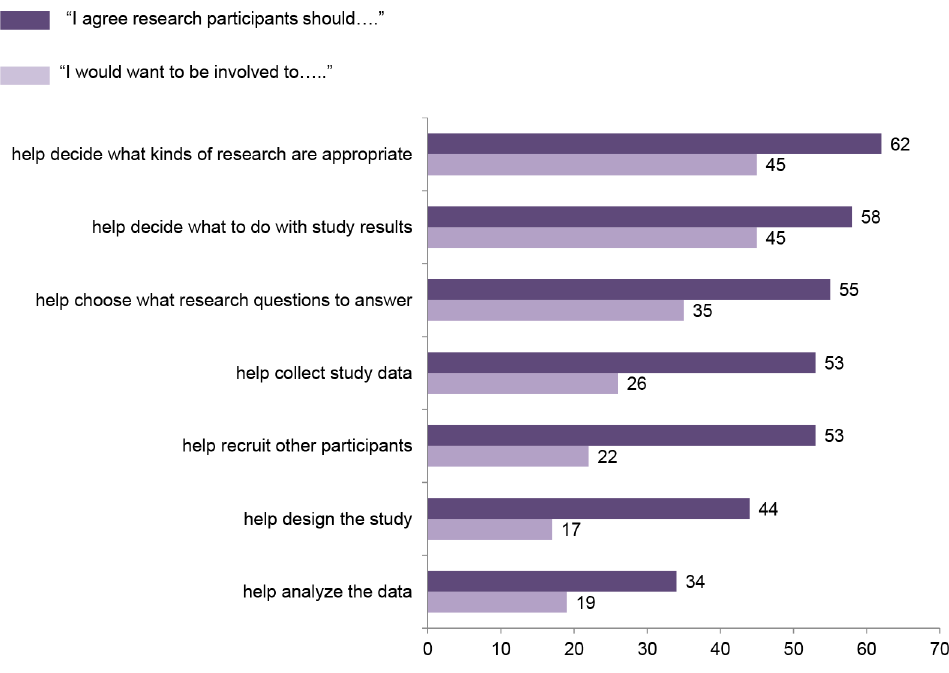
Fig 3. Results of a survey of 2,601 U.S. adults about participation in a nationwide longitudinal study of genes and environment. Aspects of the study that participants should be involved in generally, and aspects the respondent themselves would want to be involved